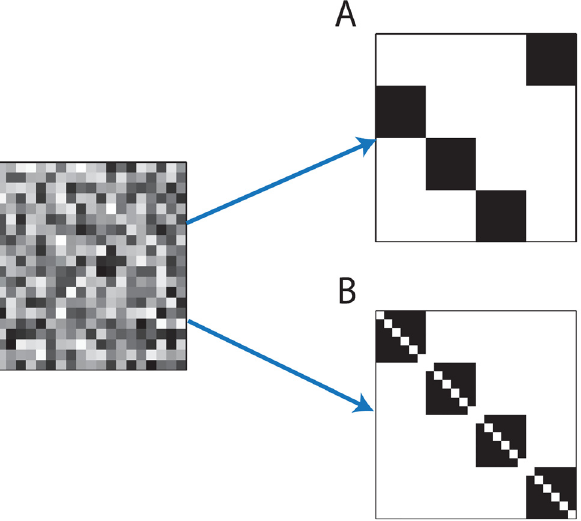
Fig 1. Spontaneous emergence of global structures from initially random network connectivity. Illustration of connectivity matrices: Left — random connectivity, A. Synfire chain connectivity, B. Self connected assemblies. In all panels horizontal (vertical) axes represent the pre (post) synaptic